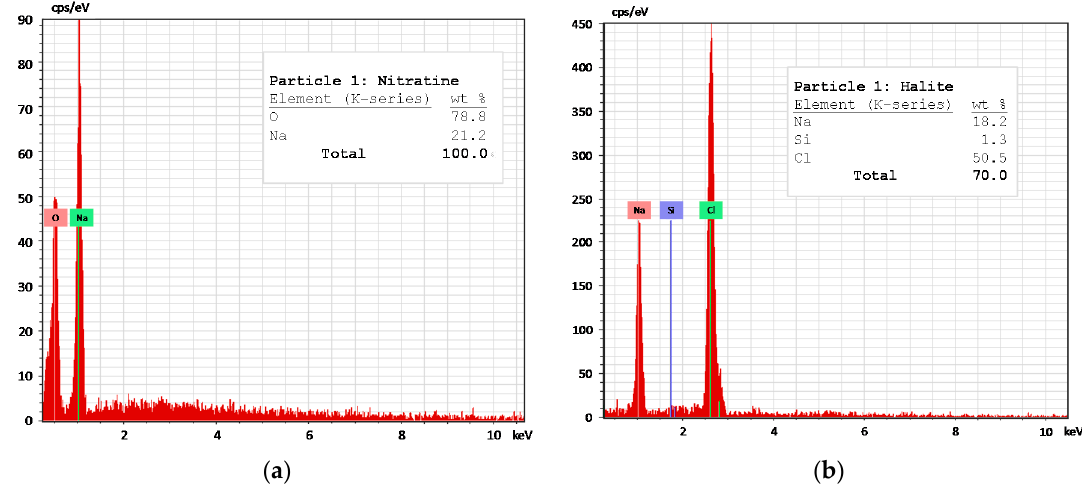
Figure A1. Spectrogram analysis of ( a ) Nitratine and ( b ) Halite.